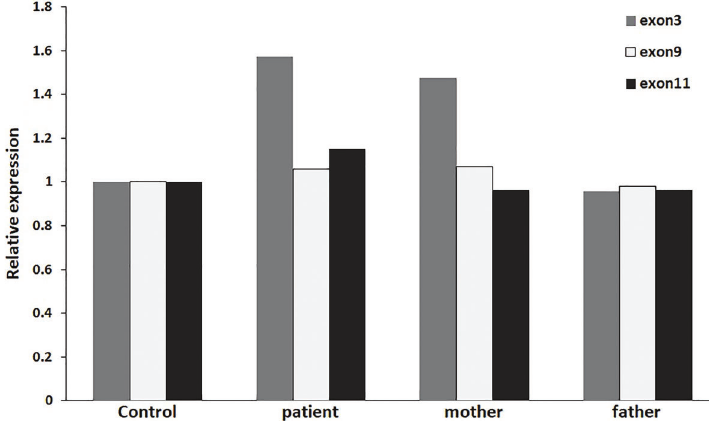
Figure 2. Relative expression of exon3, exon9 and exon11 of GSS gene in the patient and his parents. A relative expression of 1 indicates normality and a relative expression of about 1.5 indicates a repetitive sequence. qRT-PCR results showed that there was a repetitive sequence in exon3 of GSS gene in the patient and his mother